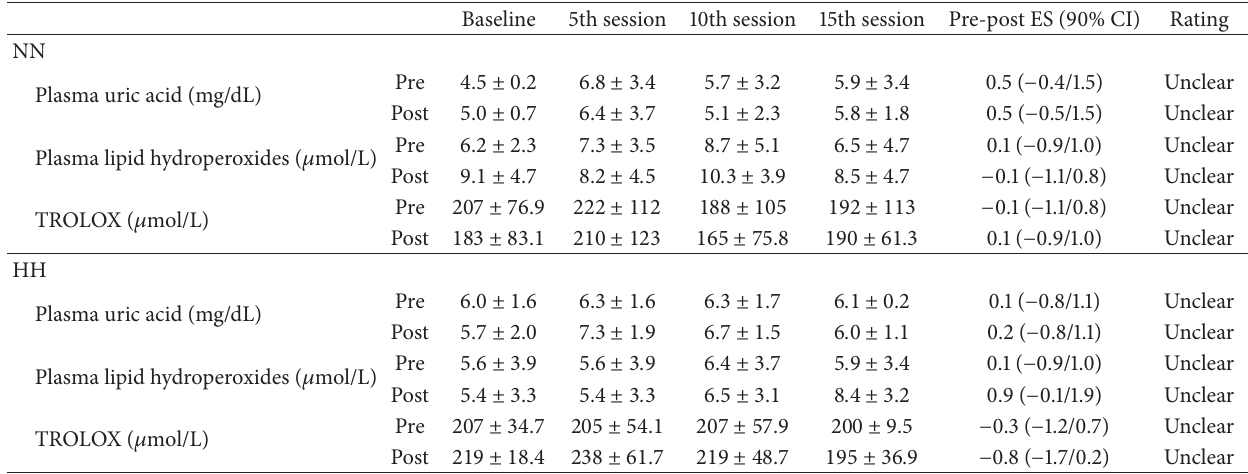
Table 2: Plasma oxidative stress markers and antioxidant capacity immediately before (pre) and after (post) the 5th, 10th, and 15th training session during 3 weeks of hyperbaric hyperoxia (HH) and normobaric normoxia (NN) endurance